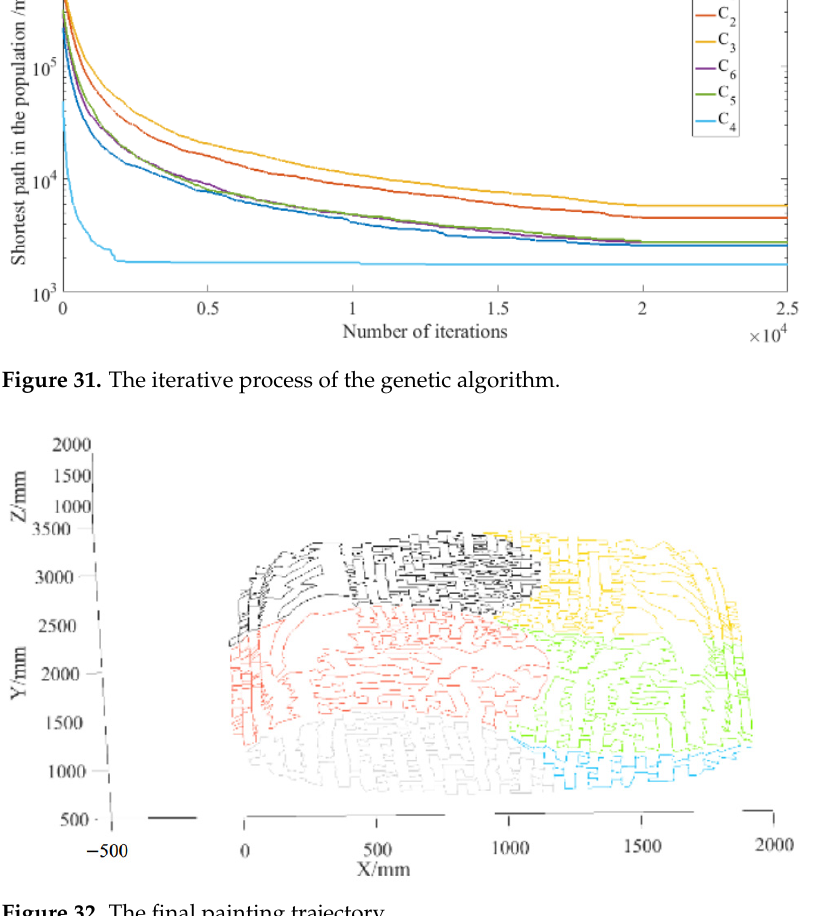
Figure 34. The UR5 robot’s axis errors. As per Figures 33 and 34, the errors are within the technical requirements of painting large objects, and the algorithm has satisfactory engineering practicability. Since the main solution in this paper was an analytical solution, when the joint radian of the UR5 robotic manipulator’s motion platform in the recommended area needed to be solved, an iterative method was harnessed to solve Equations (14) to (18). 7. Discussion and Conclusions This paper proposes an algorithm that employs a nine-axis robotic manipulator to automatically paint large objects. With the proposed algorithm, automatic processing of complex objects is achieved. The algorithm is divided into three aspects that consist of extraction of the target model, the establishment of the inverse kinematics model of the manipulator, and the planning of the target trajectory. In the section of the proposed algorithm for extracting the target model, as per the STL file of the target trajectory, the triangles of the target trajectory are extracted. A full 3D data point cloud model is obtained with a triangle-based filling algorithm. Subsequently, the PCA algorithm is harnessed to identify the normal vectors of the target points inside the point cloud model. With the normal vectors, Rodrigues’ rotation formula is harnessed to extract the pose of each point of the painting trajectory. Finally, the number of target points is compressed to reduce the time and space complexity of the algorithm so that the painting process requirements can be satisfied. In the section of the proposed algorithm where the inverse kinematics model of the manipulator is established, in conformity with the processing range of the robot, the inverse solution algorithm is divided into the inverse solution of the recommended region and the inverse solution of the non-recommended region. The corresponding inverse kinematics model is established by employing the closed solution method and SQP, respectively. During the planning of the painting trajectory, in line with the point cloud model of the target points, the minimum envelope rectangles of the target points are found. The target points are divided into different painting areas in accordance with the minimum rectangles. For each painting area, a TSP trajectory planning model based on GA is